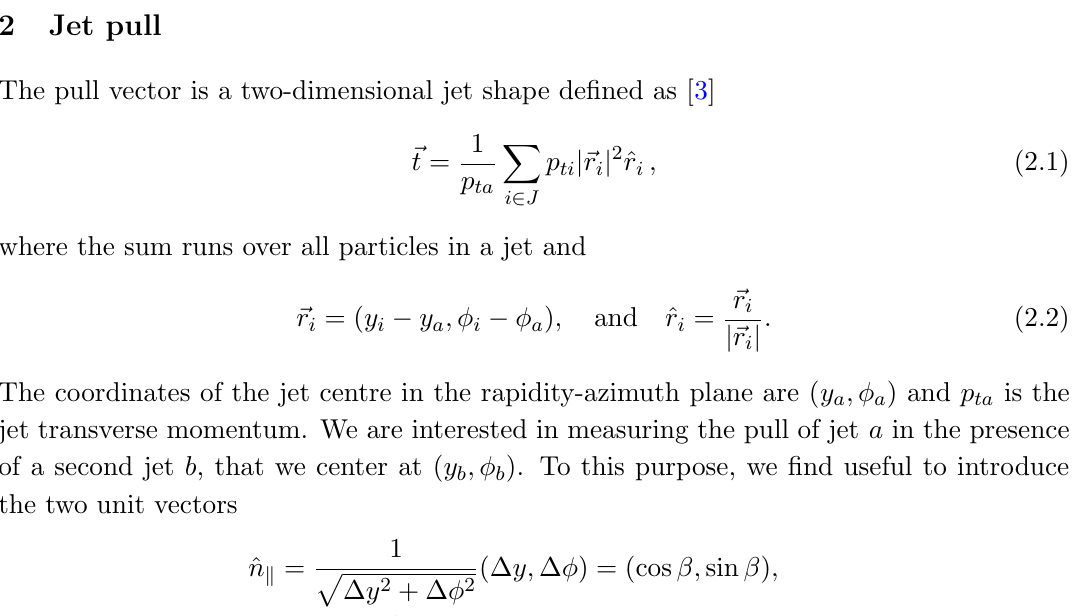
Figure 1 . A cartoon representation of the rapidity ( y ) and azimuth ( (cid:30) ) plane with the pull vector of jet a and its projections, which are de(cid:12)ned with respect the jet b